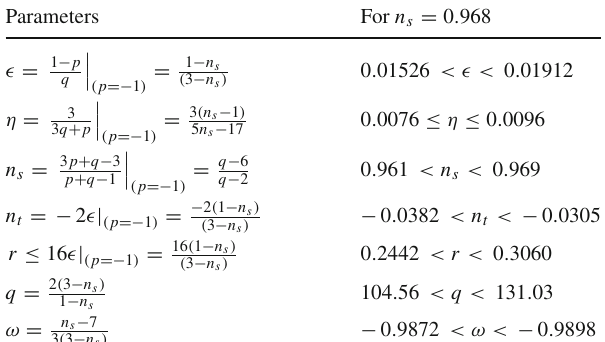
describe back-reaction effects for any equation of state. This is a great advantage over standard cosmological models where the timescale is not variable. In Fig. 1 we have plotted the plausible range of q for p = − 1, which corresponds to a spectralindex n s = 0 . 965 ± 0 . 004.Theresultsshowtherange 0 . 961 ≤ n s ≤ 0 . 969 (see Fig. 1), for which the rate of expan- sion of the universe is in the range 104 . 56 < q < 131 .